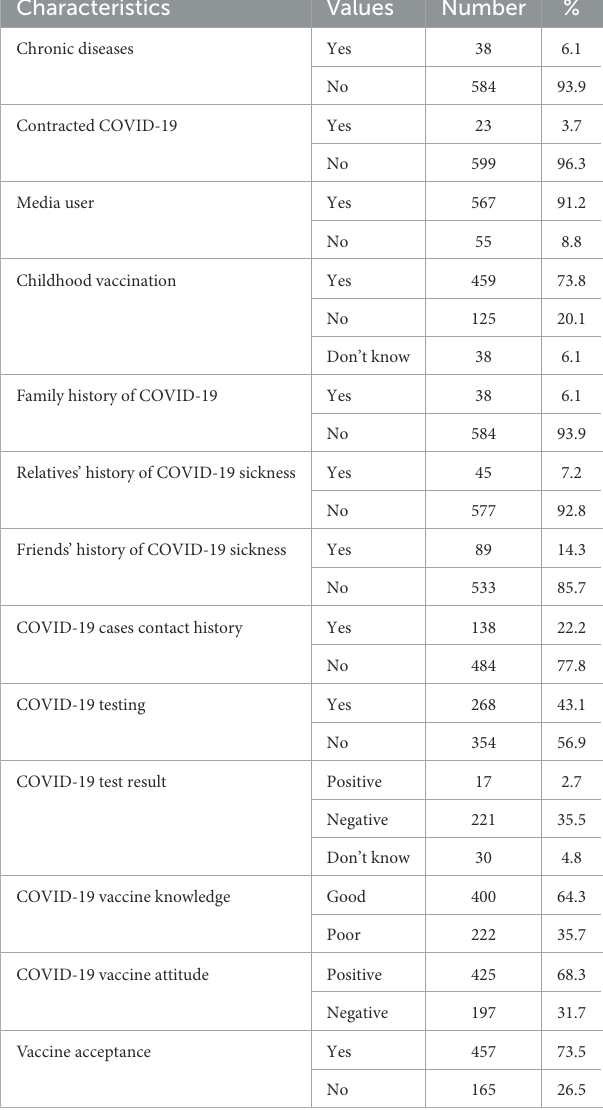
TABLE 2 Health and health-related characteristics of the study participants. Characteristics